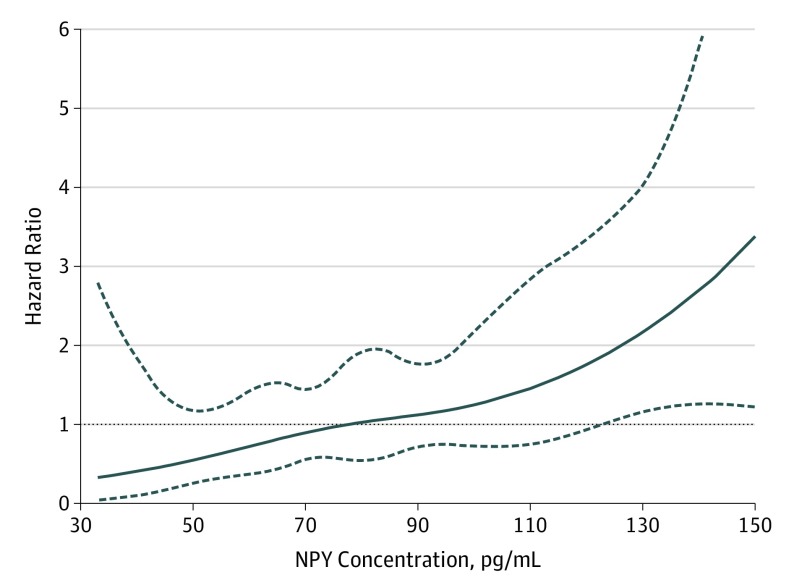
Association Between Coronary Sinus Neuropeptide Y (NPY) Level and Outcome Hazard Ratio (HR) in the CohortThe hazard ratio (solid line) and the upper and lower 95% confidence limits (dashed lines) for major adverse cardiac events (MACE), outcome of death, ventricular assist device placement, and heart transplant and heart failure hospitalization are shown for patients in the cohort (n = 105) after adjusting for age, renal function (glomerular filtration rate), and ejection fraction (LVEF).